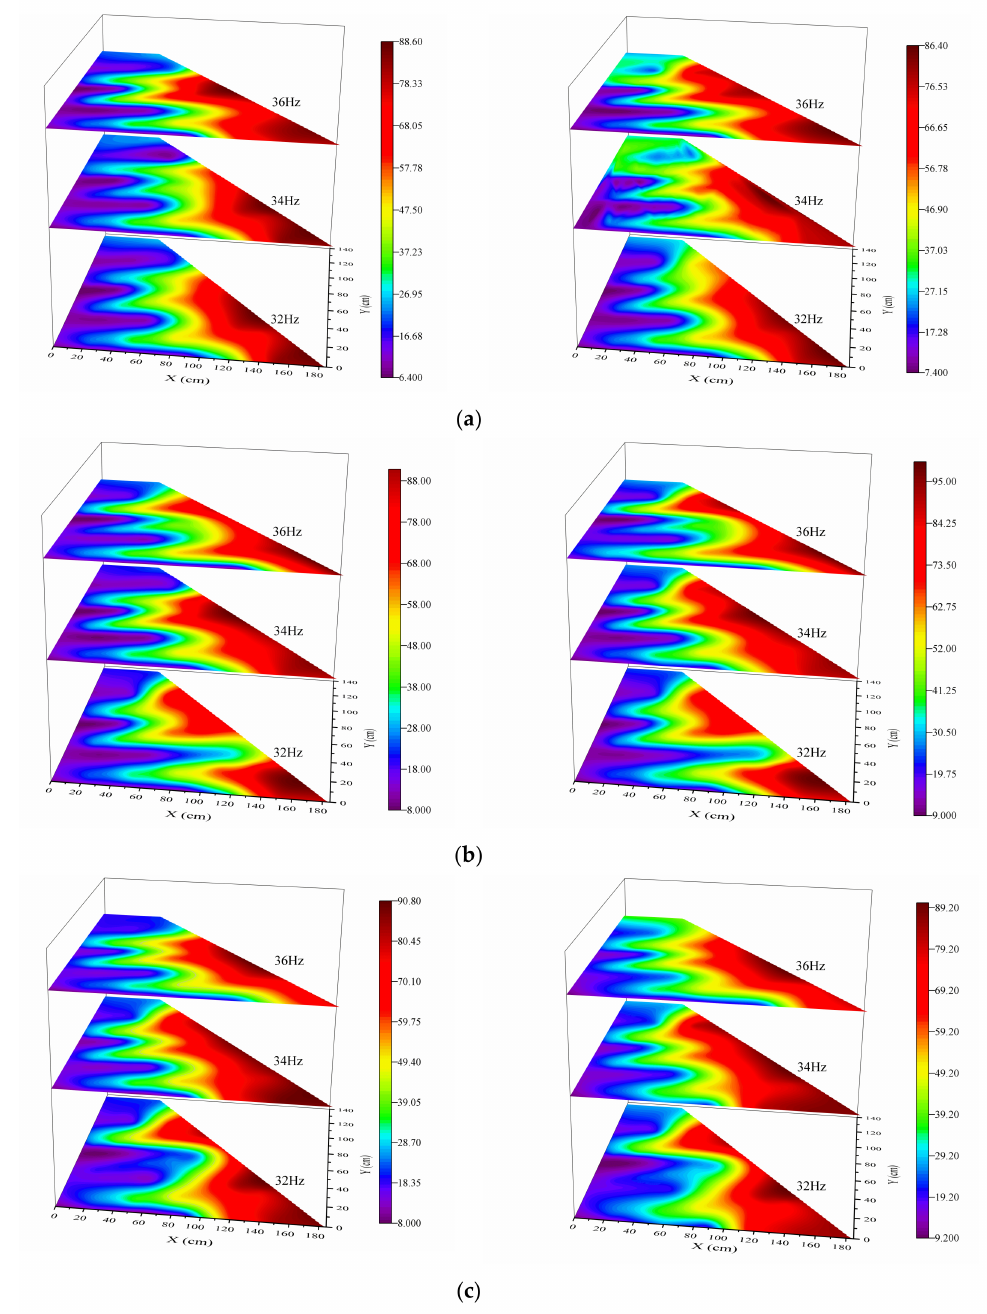
Figure 8. Ash distribution of upper layer ( left ) and lower layer ( right ) of separation bed surface. ( a ) Ash content distribution at 4.96 m/s of airflow. ( b ) Ash content distribution at 5.47 m/s of airflow. ( c ) Ash content distribution at 5.68 m/s of